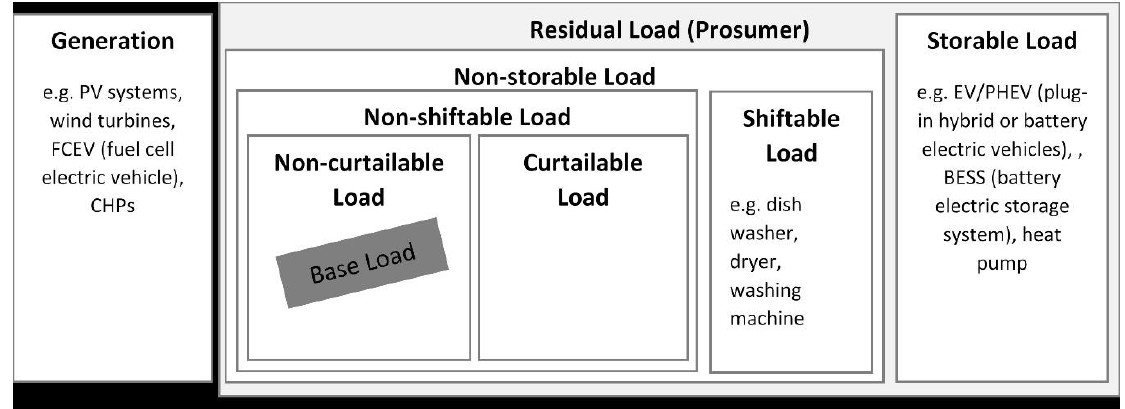
Figure 4. Prosumer residual load in terms of controllability (adapted from [57]).